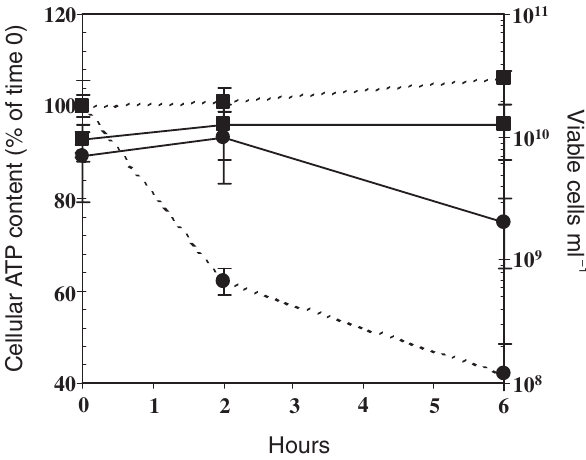
Figure 4. Cellular ATP content in the absence of sulfate. Number of viable cells ( (cid:4) , (cid:2) )and ATP contents ( (cid:4) --, (cid:2) --) from F. acidarmanus in 0.1% yeast extract acidified to pH 2.0 with either H 2 SO 4 ( (cid:4) ) or HCl ( (cid:2) ). All values represent the means of three independent trials each with two replicates. Error bars represent the standard error of the mean.